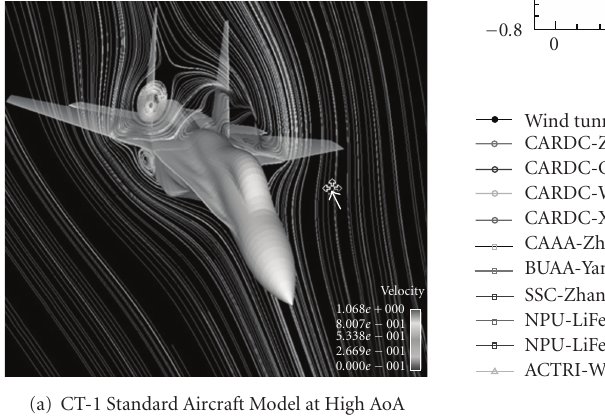
Figure 5: A typical computational result for high AoA model from the 2nd National CFD Uniform Test Cases Computation Workshop.